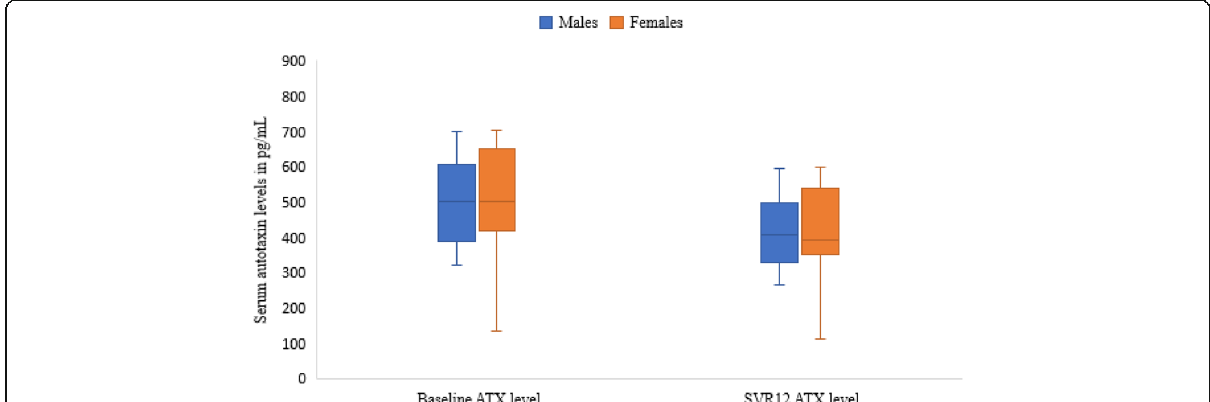
Fig. 1 Serum autotaxin levels in male and female patients at baseline and SVR12